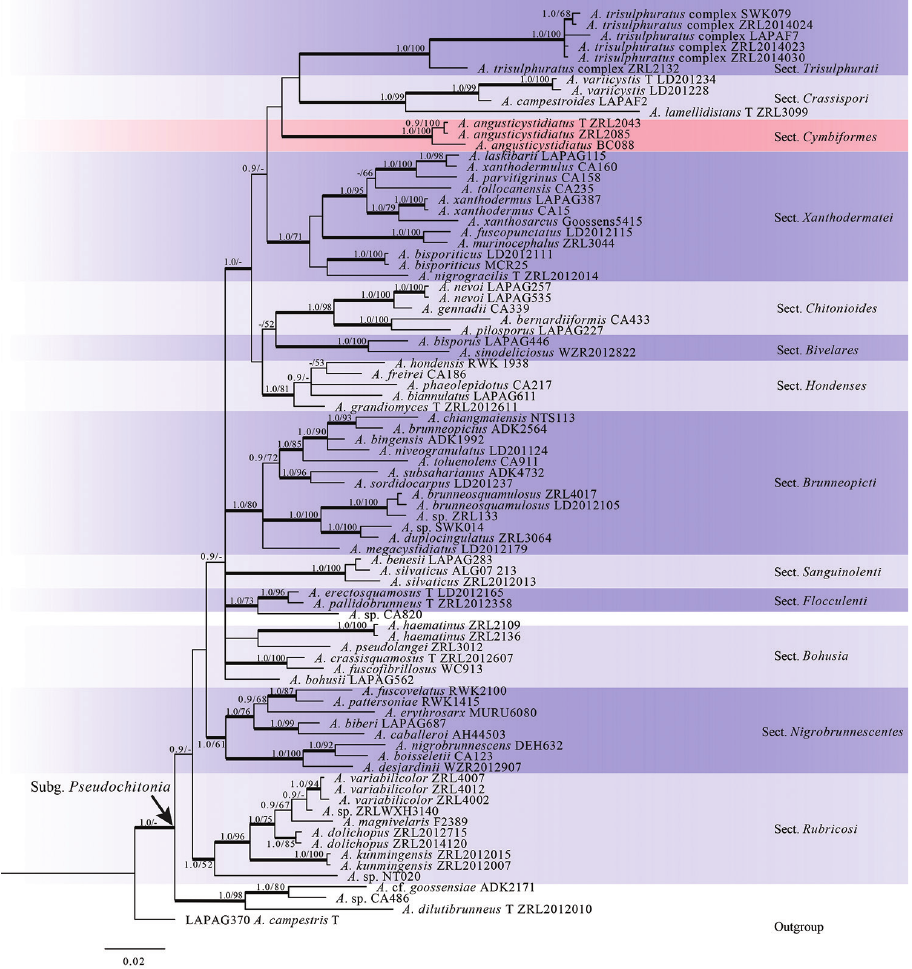
Figure 1. Phylogenetic tree of Agaricus subgenus Pseudochitonia generated from Bayesian analysis of ITS sequences, rooted with A. campestris . Bayesian posterior probability (PP) values ≥ 0.9 or Bootstrap support (BS) values ≥ 50% are indicated at the internodes (PP/BS). The branches in bold mean the related PP > 0.95, “T” refers to sequences from type